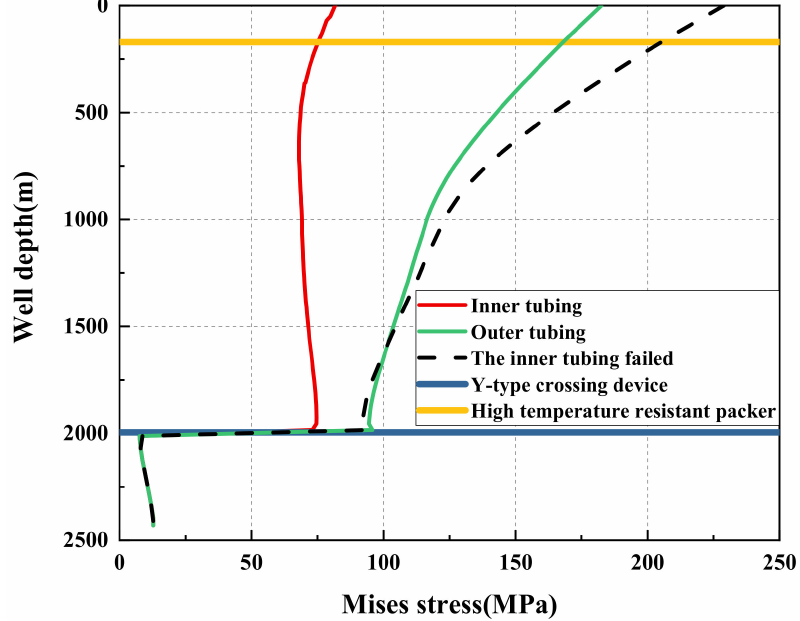
Figure 11. The von-Mises stress distribution of integrated injection-production